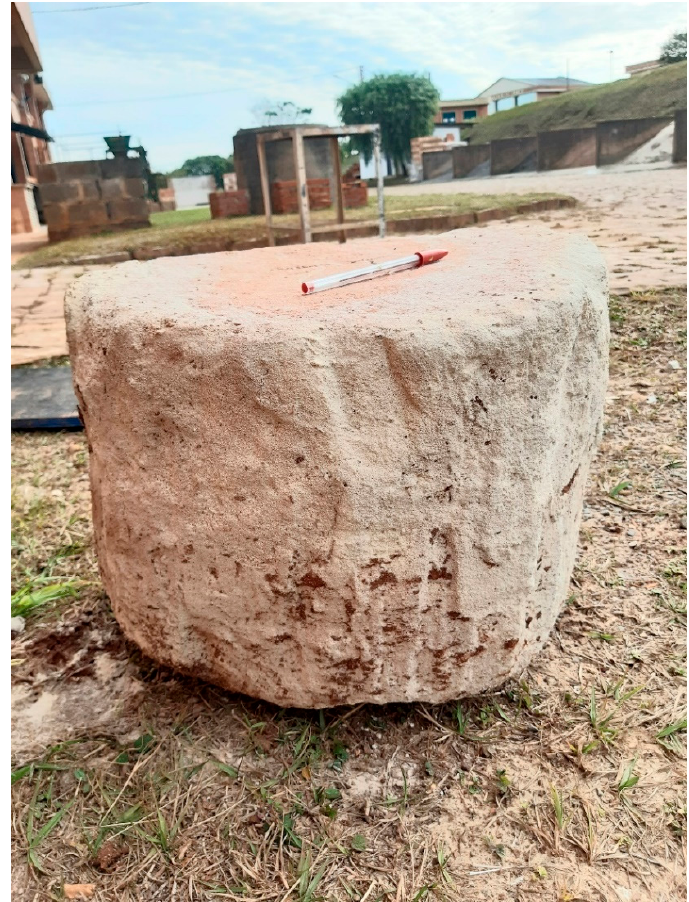
Figure 14. D r 450 mm B SHS stabilized layer exhumed from the soil. The larger diameters (D r 900B SHS and D r 900B H2O ) showed a different failure mode, characterized by punching shear, which resulted in the clear separation of a cylinder located beneath the circular plate from the remaining body of the stabilized layers (Figure 15). Some tension cracks were also formed inside the cylinder when it tried to expand laterally due to the Poisson’s effect. Additionally, two or three radial cracks developed from the center to the edges. Similar failure modes and cracking patterns were found by [11,24], soil stabilized with Portland